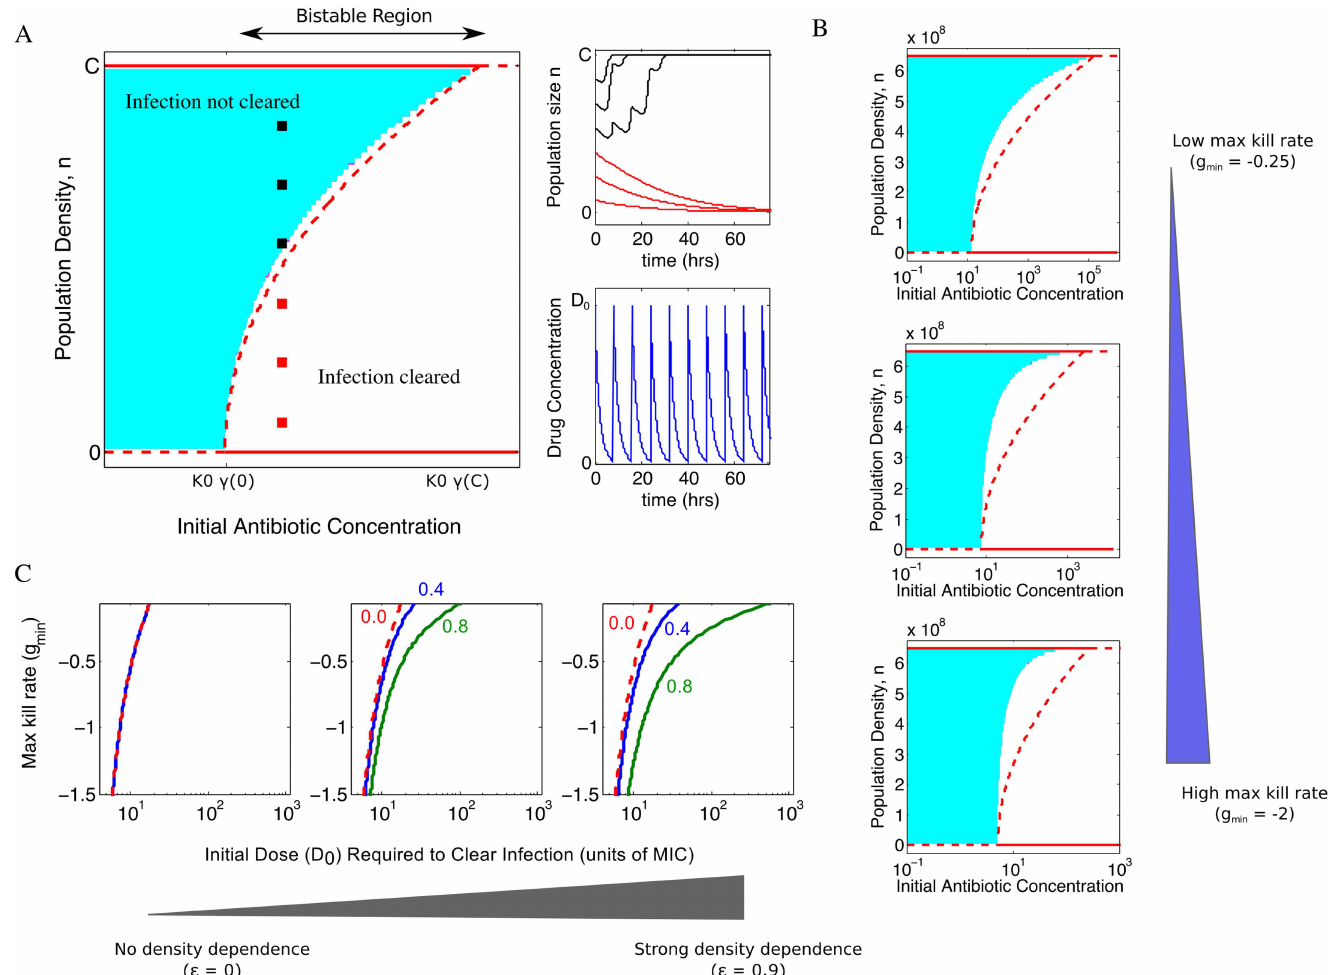
Fig 5. Density dependence of antibiotic leads to bistable treatment outcomes and potential treatment failure in a pharmacokinetic / pharmakodynamic (PK/PD) model of infection. A. Main panel : Theoretical (solid and dashed lines) and numerical(shaded region) phase diagrams indicate treatment outcomes in PK/PD model as a function of initial cell density (rangingfrom 0 to the carrying capacity, C) and initial antibiotic concentration D 0 . Solid red lines, stable fixed points of populationdensity (theory). Dashed red lines, unstable fixed points (theory). The curved dashed red line is the phase boundary(separatrix) indicatingthe critical density above which a populationwill survive. A region of growth bistability, where treatment can lead to success or failure depending on initial cell density, exists for antibiotic concentrations K 0 γ (0) (cid:20) D 0 (cid:20) K 0 γ ( C ), where K 0 is the MIC and γ (n) is a nonlinearfunction that depends on the maximum drug kill rate (g min ), the Hill coefficient (h), the drug decay rate (k d ), and the dosing period T (S1 Text). Shaded regionsindicate treatment failure in numericalsolutions of the PK/PD model. Upper right inset: numericalsolution of PK/PD equations for five different initial densities (indicated by red and black squares on the phase diagram). Lower inset: temporal dynamics of antibioticconcentration. For numericalphase diagram and simulations, g min = -0.05 and ε = 0.9. Simulationsin insets correspond to D 0 = 200 (in units of MIC, K 0 ). B. Phase diagrams from both theory (solid and dashed lines) and numericalsimulations (shaded region) for increasingmaximum kill rates (g min = -0.25, -1, -2 from top to bottom) and populationsdensities on the order of 10 8 cells/mL (corresponding to the OD ranges measuredhere). g min is measured in units of g max ; biologically, g max (cid:25) 1 hr -1 for bacteria, so one can also view these units as inverse hours. C. Initial dose of antibiotic(units of MIC, K 0 ) requiredto clear infections of density OD = 0 (dashedred), OD = 0.4 (blue line), and OD = 0.8 (red line) for different maximum kill rates for the case with no density dependence ( ε = 0, left), modest density dependence ( ε = 0.5, middle), and strong density dependence( ε = 0.9, right). In all panels, the Hill coefficient h = 2, k d = ½ , and T = 8, corresponding to a treatment period of 8 hours and a natural drug decay rate of ½ hr -1 . Qualitatively similar results are found for other parameters(Figure G of S1